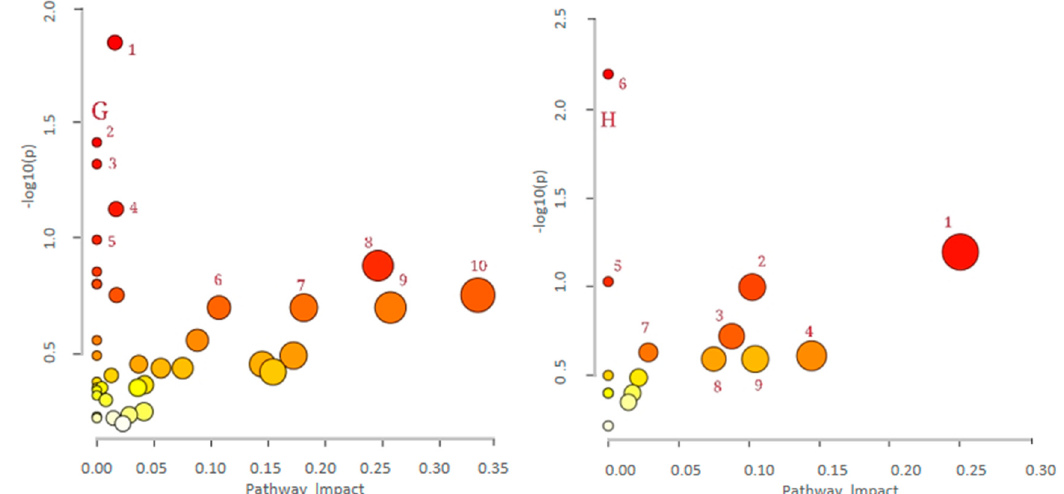
Figure 5. Enrichment maps of downregulated metabolic pathways in negative and positive modes. Negative ion mode: ( A ) LPS vs. QF 0.1; ( B ) LPS vs. QF 1; ( C ) LPS vs. QF 10; ( H ) Control vs. LPS. Positive ion mode: ( D ) LPS vs. QF 0.1; ( E ) LPS vs. QF 1; ( F ) LPS vs. QF 10; ( G ) Control vs. LPS. Data point descriptions are in Table 2. Table 2. Enrichment maps’ description of downregulated metabolic pathways.